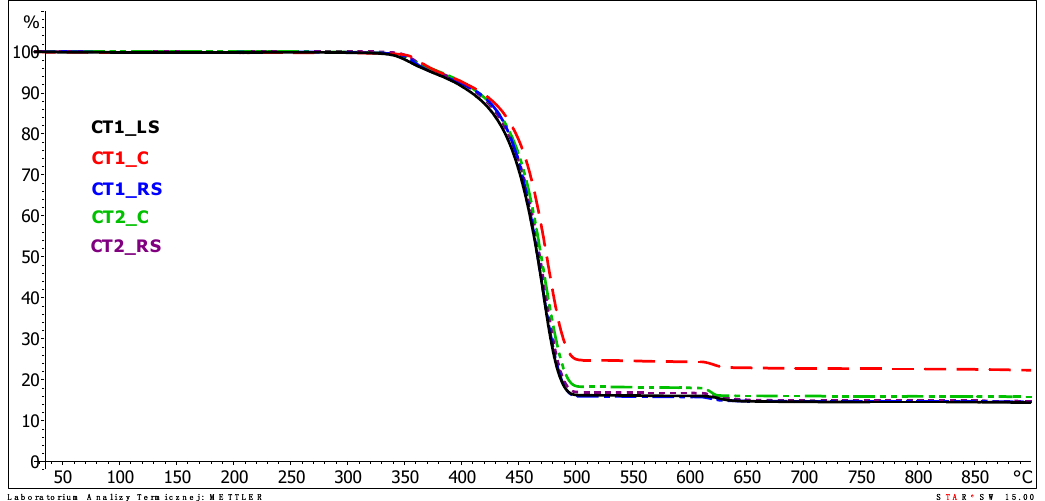
Figure 15. TGA curves of tested samples.